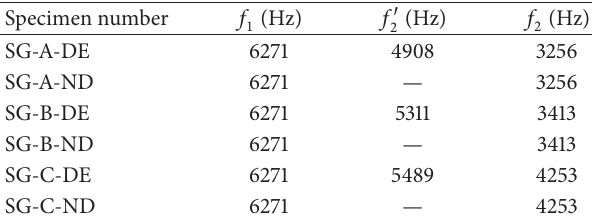
Table 3: Theoretical peak frequencies.